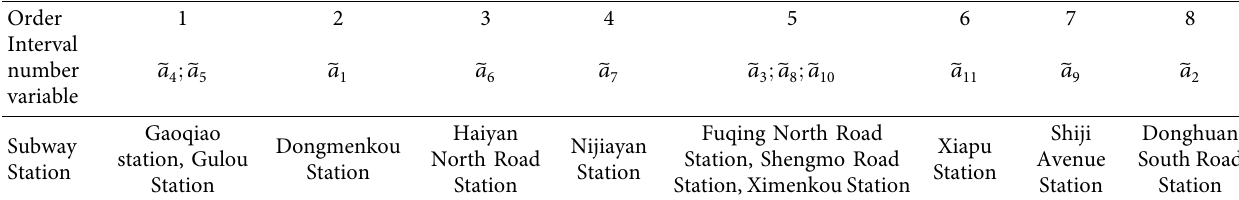
Table 6: Ranking result of interval numbers under traditional interval number